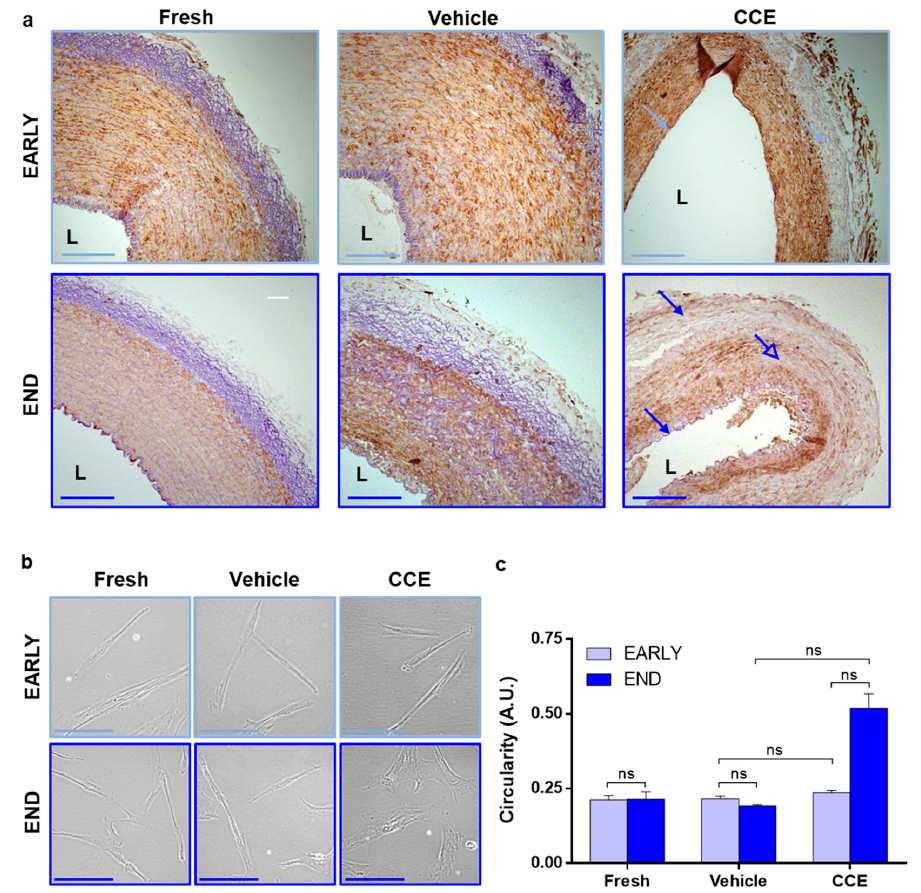
Figure 2. Tissue and cellular morphology from EARLY and END models. ( a ) Tissue was fixed and stained with Miller’s elastin for elastic fibres and α -SMA to identify SMC content. Images captured at ×100 magnification; L = lumen; closed arrows = elastin loss; open arrow = SMC loss; scale bar = 200µm. ( b ) SMC were isolated from FRESH tissue or after 3 (EARLY) or 12 days (END) in the bioreactor. Images captured at 400× magnification; scale bar = 100µm. ( c ) The outline of 50 cells per condition per animal was measured, and their circularity calculated. All n = 3, significance assessed using the Kruskal–Wallis test and the Mann–Whitney test with Benjamini–Hochberg correction for multiple comparisons. ns: not significant.